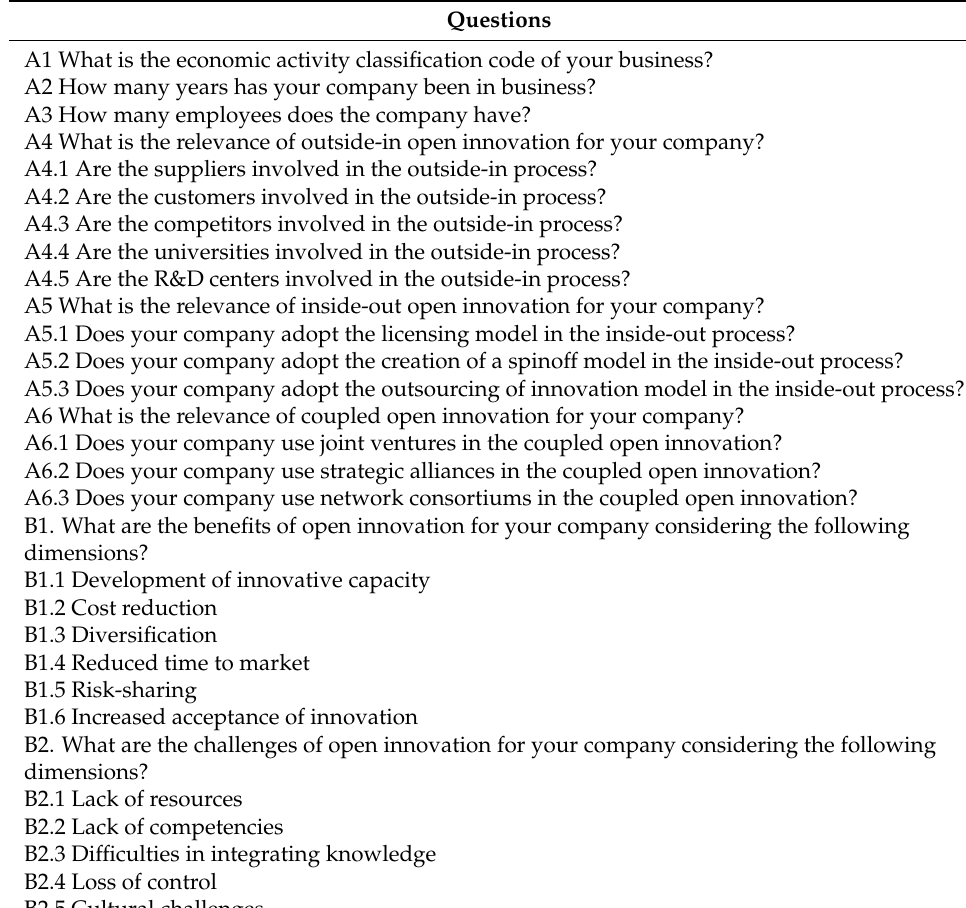
Table A1. Full structure of the